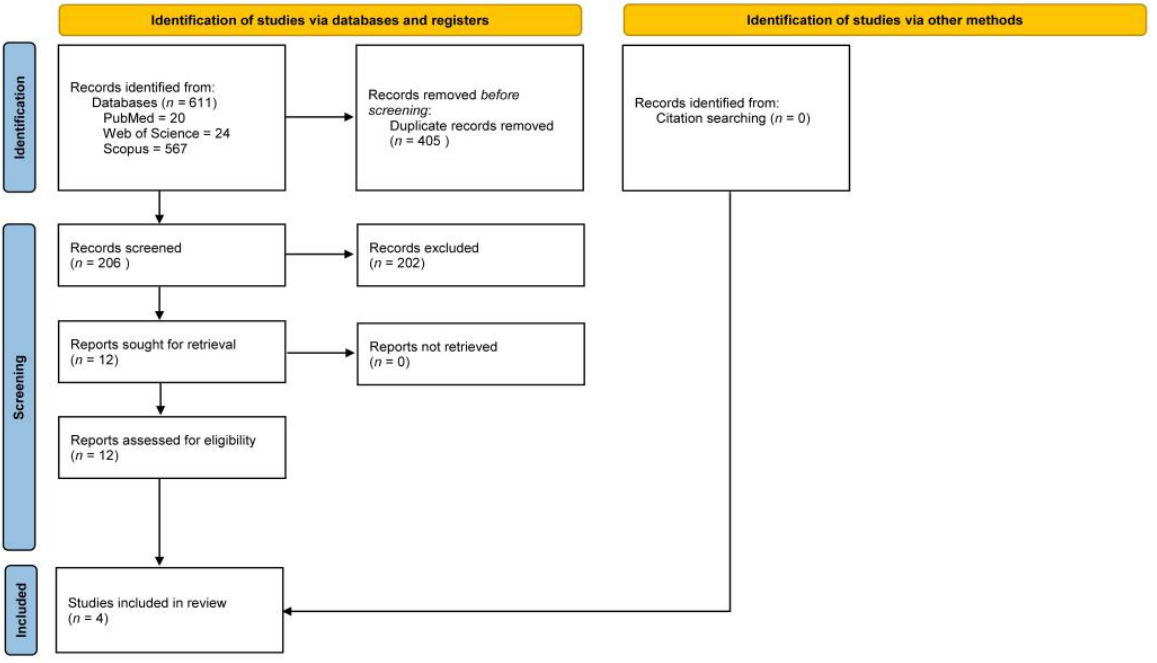
Figure 1. PRISMA flow diagram of the review.